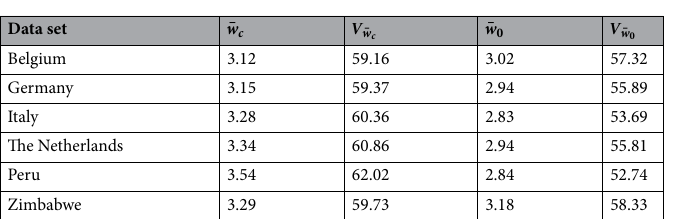
Table 3. Mean vaccination coverage (in %) at the critical per capita vaccination rate ¯ w c (in %) under the uniformly random vaccination strategy, and at the mean per capita vaccination rate ¯ w 0 (in %) at the DFE for which R ∗ 0 ≈ 0.996 . 100% vaccine efficacy is assumed in both